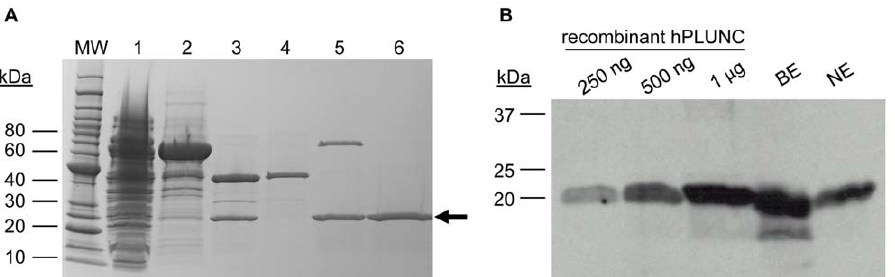
Figure 2. Expression and purification of recombinant human PLUNC. (A) Recombinant PLUNC protein was expressed in E. coli as described in the Methods. After centrifugation, the crude bacterial lysate (Lane 1) was passed over amylose resin and bound fusion protein was eluted from the resin using maltose. The recovered elution fraction (Lane 2) indicated a predominant product of approximately 69 kDa on a reducing SDS-PAGE gel, consistent with the predicted size of the MBP-PLUNC-6xHis fusion protein. Fusion protein was further purified by gel filtration, followed by a 16 hour cleavage with Factor Xa protease to remove the MBP tag. Factor Xa treatment gave rise to two cleavage products, MBP at 43 kDa and PLUNC-6xHis at approximately 26 kDa (Lane 3). After passing the cleavage products over nickel resin, MBP was observed in the flowthrough fraction (Lane 4), while the elution fractions contained PLUNC-6xHis and any remaining uncleaved His-tagged fusion protein (Lane 5). A final gel filtration step was used to separate PLUNC-6xHis from the uncleaved protein (Lane 6). Cleaved PLUNC-6xHis, in its final form, is indicated by the arrow. MW = molecular weight ladder (BenchMark Unstained Protein Standard; BioRad) (B) Representative immunoblot, in which increasing concentrations of purified recombinant PLUNC-6xHis were electrophoresed and probed using a monoclonal antibody directed against the human PLUNC protein, revealing a single immunoreactive band at the expected molecular weight in the range of 20–25 kDa. Immunoblotting also demonstrated the presence of native PLUNC protein in apical secretions from primary cultures of well-differentiated human bronchial epithelia (BE) and nasal epithelia (NE). See Methods for details.